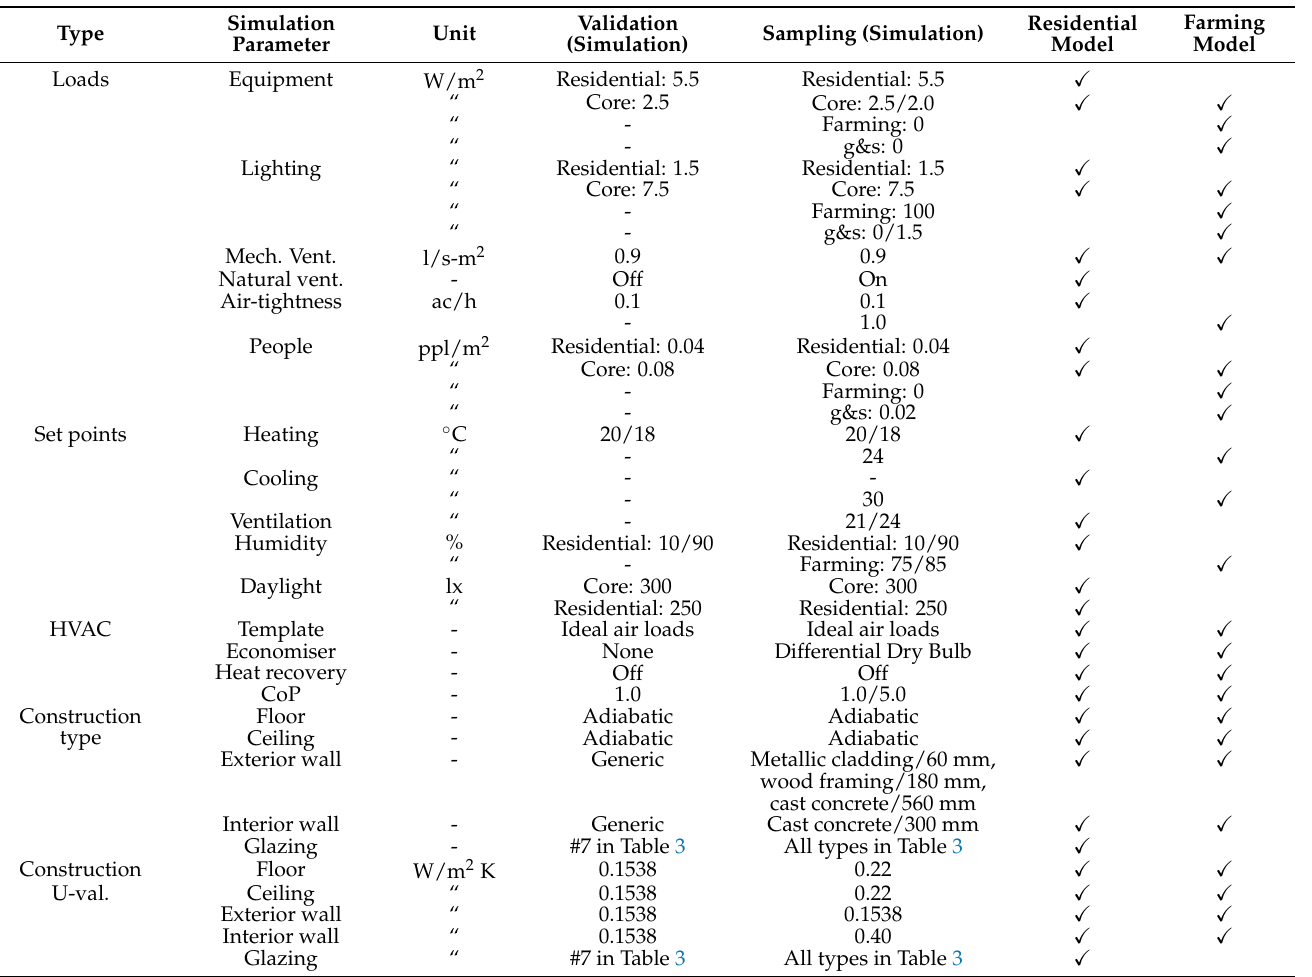
Figure 6. Schedules used in residential energy model. Table 4. Inputs of the energy models.